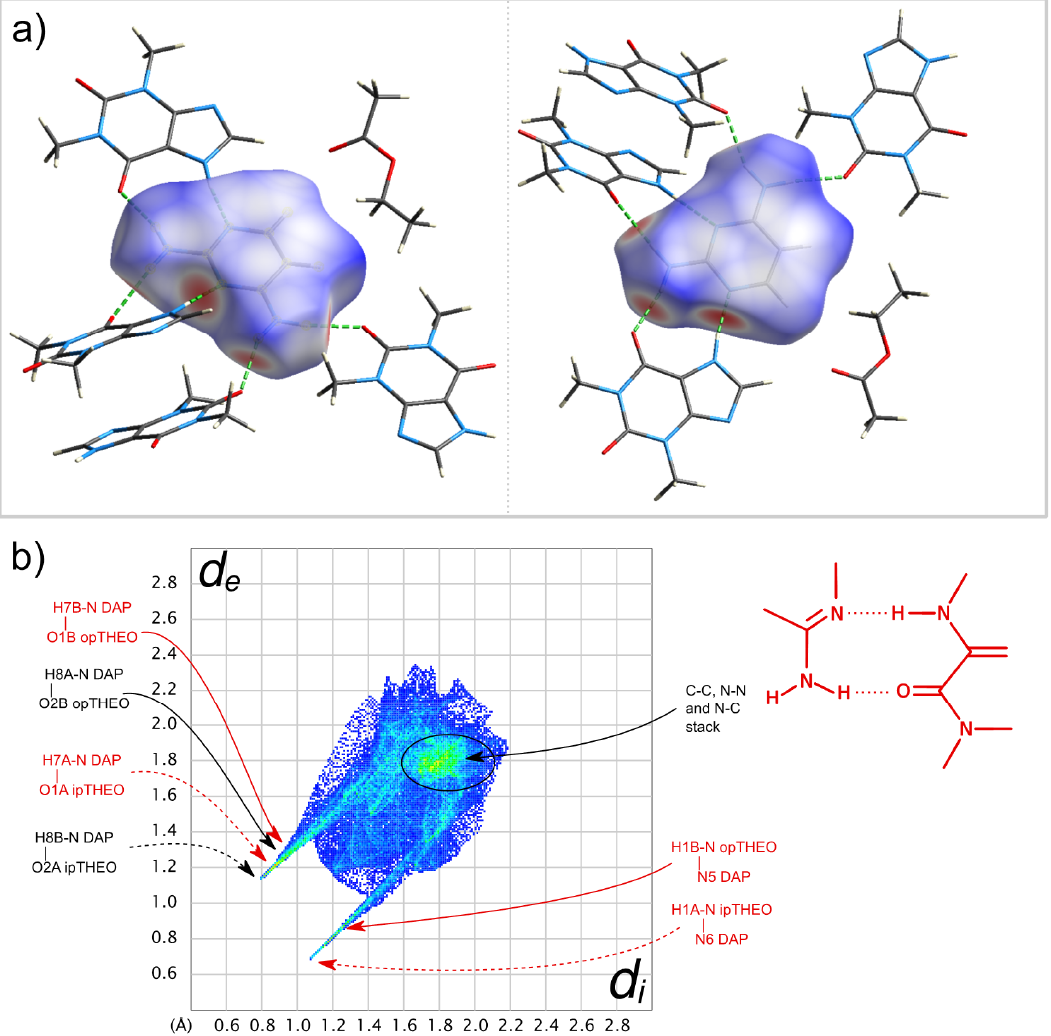
Figure 15. ( a ) Two views of the close contacts of the semitransparent d norm -mapped Hirshfeld surface of DAP molecule. ( b ) Hirshfeld fingerprint plot of the DAP molecule in the (1:2:1) DAP:THEO:EtAc co-crystal solvate. Some important pairs of contacting atoms are identified and assigned to fingerprint plot features, with dashed arrows for “in-plane” (ipTHEO) and solid arrows for “out-of-plane” (opTHEO) THEO molecules. Contacts within the R 2 2 (9) synthon between the DAP scaffold and THEO, shown at the side, are colored in red. d i —the distance (Å) from the Hirschfeld surface to the nearest atom center in its interior; d e —distance (Å) from the Hirschfeld surface to the nearest atom center in its exterior.